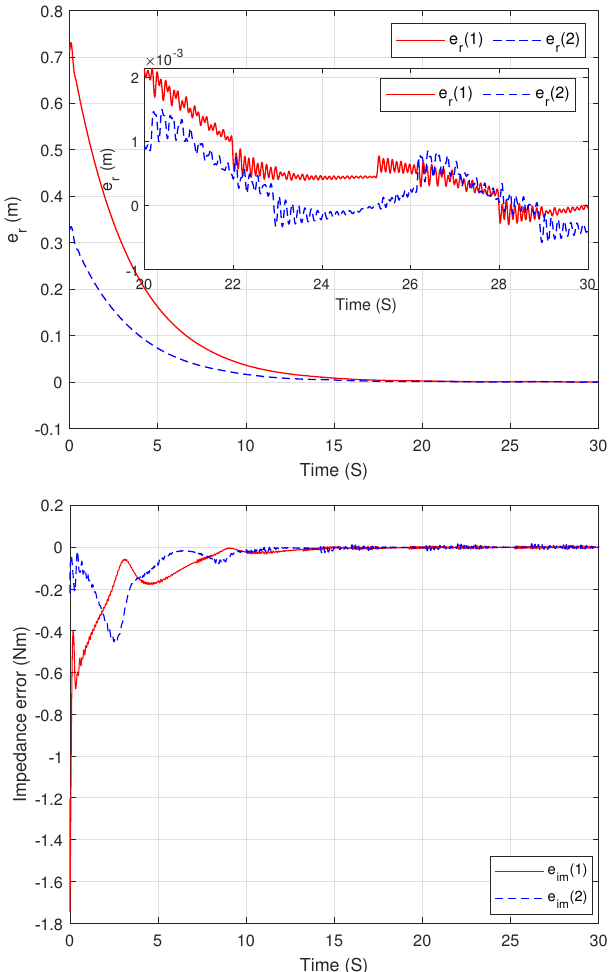
Figure 7. The tracking performance for the admittance trajectory and impedance